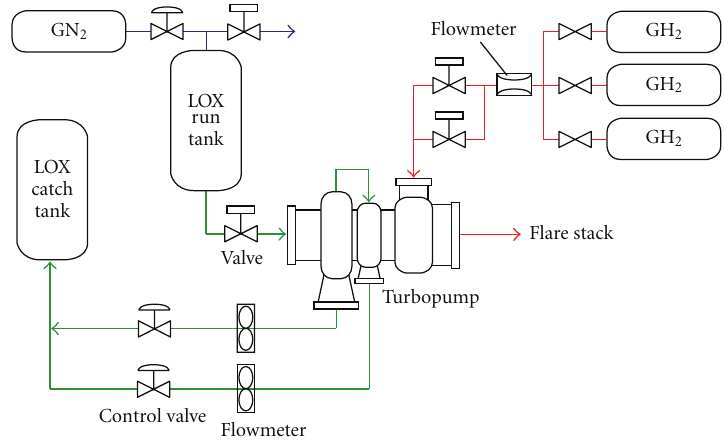
Figure 1: Schematic diagram of turbopump test facility.